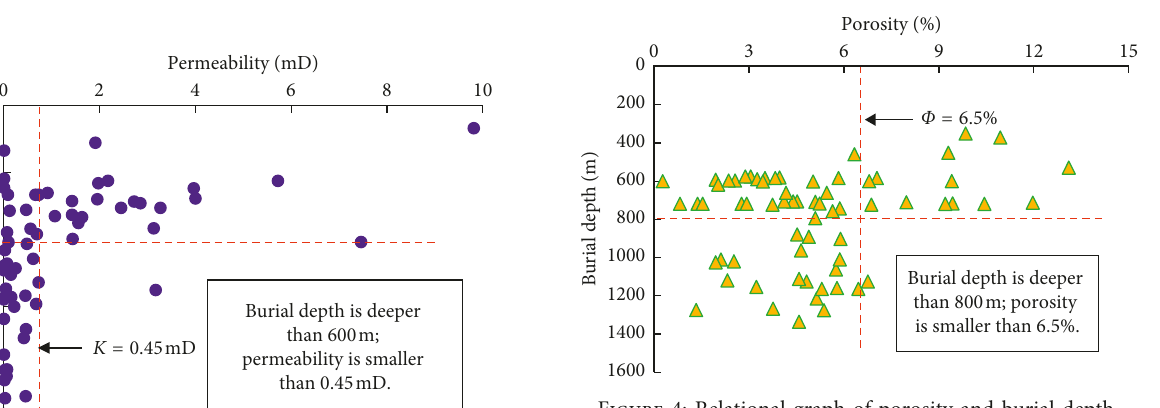
Figure 1: Box plot of permeability and burial depth in Qinshui Basin.